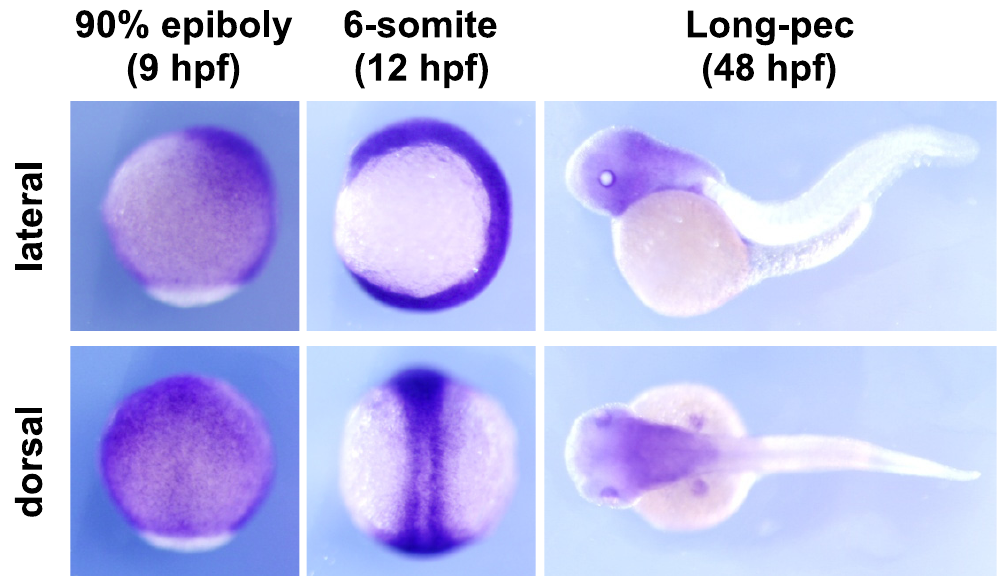
Figure A1. celf1 expression in zebrafish embryos. Lateral ( upper panels ) and dorsal views ( lower panels ). We could observe dotted signals at 9 hpf ( left panels ), reminiscent for the distribution of endoderm cells in this stage (see also Figure 1A). Although endoderm cells distributed in a salt and pepper pattern at 12 hpf as shown in Figure 1C, the salt and pepper distribution of celf1 could not be seen in embryos at 12 hpf. At 48 hpf, celf1 was expressed in pectoral fins, heads and eyes, but not in endoderm-derived organs. Because mouse Celf1 and chick Celf1 are expressed in livers [26–30], we think that the expression patterns of celf1 are specific for